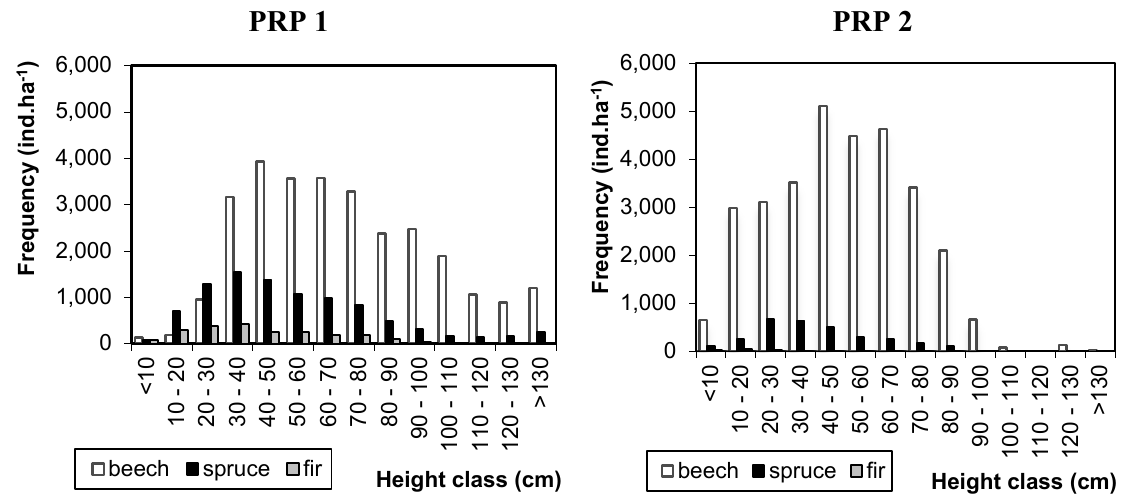
Figure 3. H istogram of the height structure of recruits on Černý důl PRP 1 (fenced) and PRP 2 (unfenced) as converted per 1 ha. PRP 1 PRP